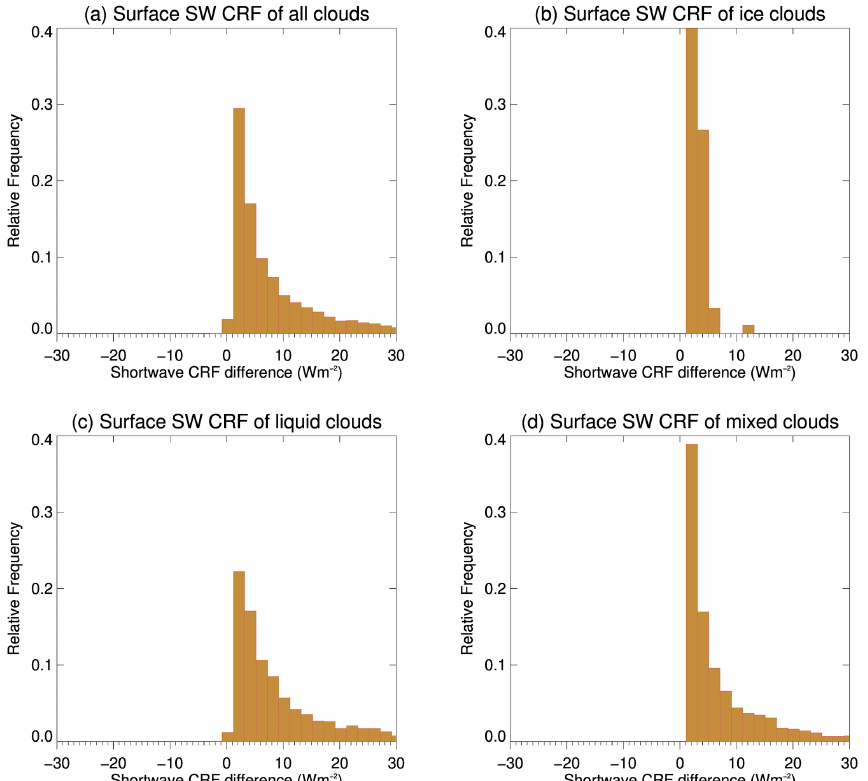
Figure 11. Histogram of shortwave cloud radiative forcing at the surface using clouds identified by combined CloudSat and CALIPSO and clouds from surface observations during the SHEBA experiment for (a) all clouds, (b) ice clouds, (c) liquid clouds and (d) mixed-phase clouds. Ratios of cases with absolute differences less than 1Wm − 2 to all cases are 40.5%, 91.3%, 18.4%, and 39.6%, for panels (a) , (b) , (c) and (d) , while being excluded from the